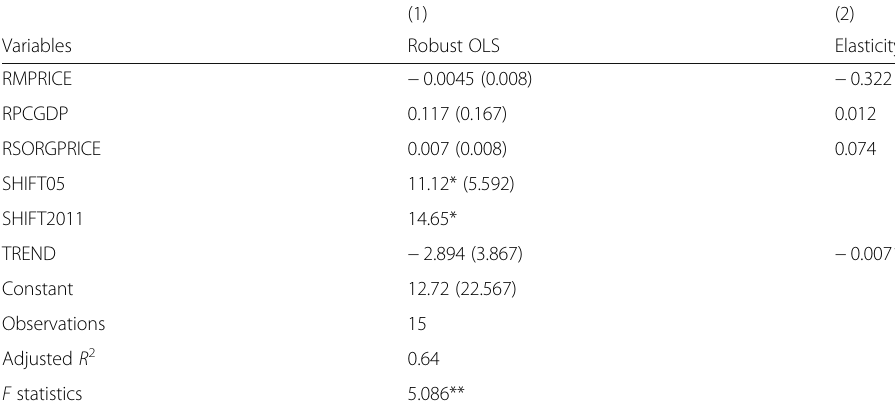
Table 6 Results for per capita maize consumption (1)